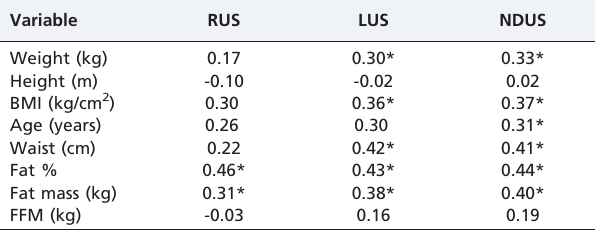
The presented values are the Spearman Correlation Coefficients. * p ,